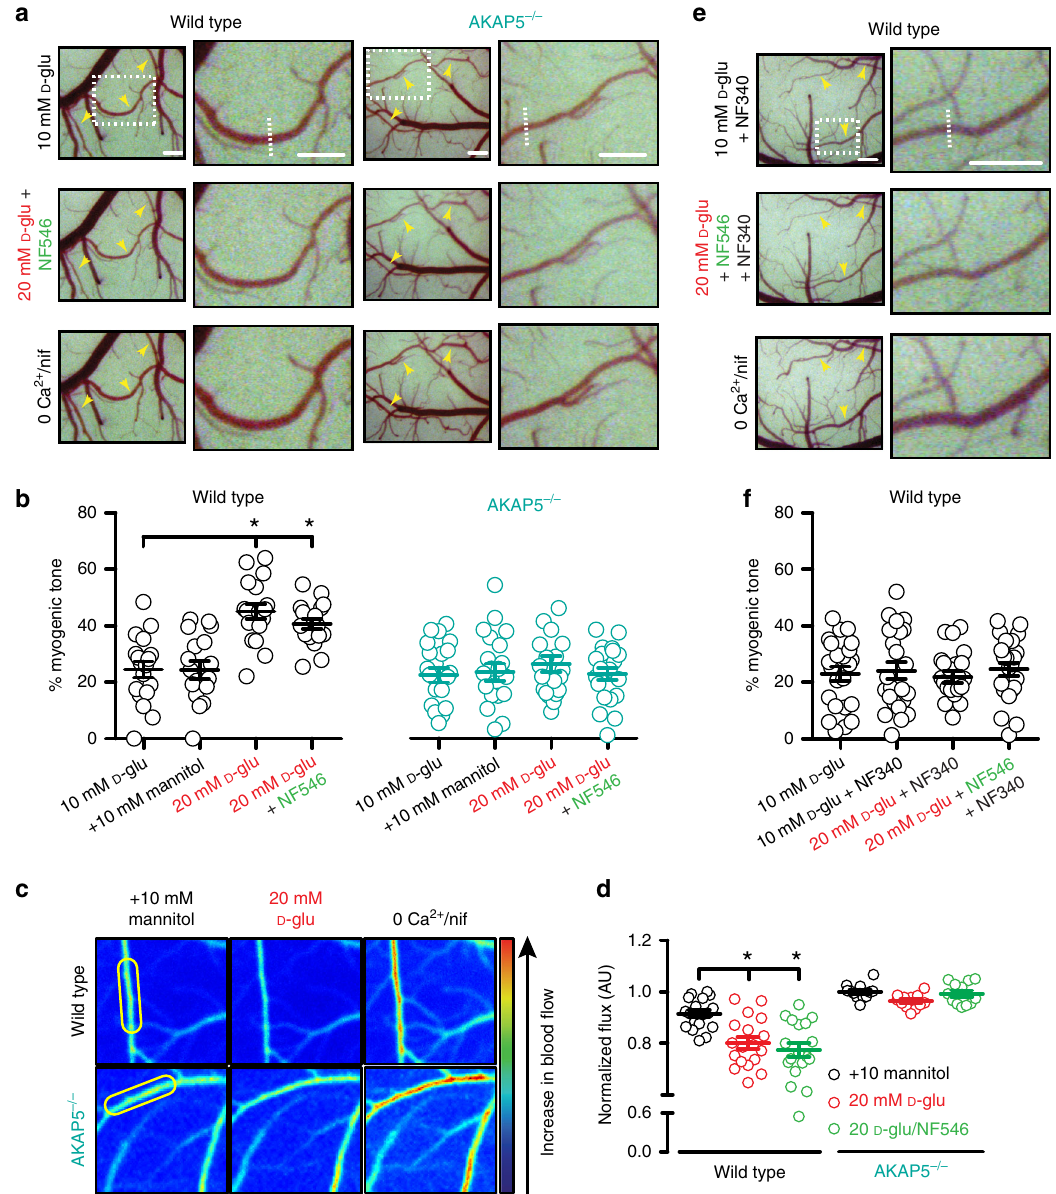
Fig. 4 Glucose/NF546 effects on myogenic tone/blood fl ow require AKAP5. a Exemplary open cranial window images of wild-type (WT; n = 18 arteries/ 3 mice) and AKAP5 − / − ( n = 21 arteries/3 mice) middle cerebral arteries and branches exposed to 10 mM D-glucose (D-glu), 20 mM D-glu + NF546, and 0 Ca 2 + + 1 μ M nifedipine (nif). b Summary myogenic tone data. * P < 0.05 with Friedman one-way ANOVA with Dunn ’ s multiple comparisons. Signi fi cance was compared to the 10 mM D-glu group. P < 0.0001 for WT 10 mM D-glu-20 mM D-glu and P = 0.0004 for WT 10 mM D-glu-20 mM D-glu + NF546. c Representative pseudo - colored blood fl ow images of cerebral pial arteries through a cranial window exposed to 10 mM D-glu + 10 mM mannitol, 20 mM D-glu, and 0 Ca 2 + + 1 μ M nif in WT and AKAP5 − / − mice. d Summary blood fl ow data in WT ( n = 18 arteries/5 mice) and AKAP5 − / − ( n = 12 arteries/3 mice) mice. * P < 0.05 with Friedman one-way ANOVA with Dunn ’ s multiple comparisons. Signi fi cance was compared to the + 10 mM mannitol group. P = 0.0007 for WT mannitol-20 mM D-glu and P < 0.0001 for WT mannitol-20 mM D-glu + NF546. The yellow ovals highlight regions that were used for analysis. e Representative open cranial window images of WT ( n = 23 arteries/3 mice) middle cerebral arteries and branches in 10 mM D-glu + 10 µ M NF340, 20 mM D-glu + 500 nM NF546 + 10 µ M NF340, and 0 Ca 2 + + 1 µ M nif. f Amalgamated myogenic tone data. * P < 0.05, Friedman one-way ANOVA with Dunn ’ s multiple comparisons. Signi fi cance was compared to the 10 mM D-glucose group. Data represent mean ± SEM. In ( a ) and ( e ), yellow arrows = arteries, dotted rectangles highlight zoom regions on the right side panels, and dotted lines in the zoom images highlight regions that were used for analysis. Scale bars = 50 pixels for the main fi gures and 70 pixels for the insets. Source data are provided as Source data fi AKAP5 orchestrates the P2Y 11 /AC5/PKA/Ca V 1.2 nanocomplex . To complement and expand on the super-resolution data, we used the proximity ligation assay (PLA) 53 . This assay emits a fl uorescent signal only when proteins of interest are at least within 40 nm of each other 53 (as extensively validated by these authors 12,19,20,35 ). In